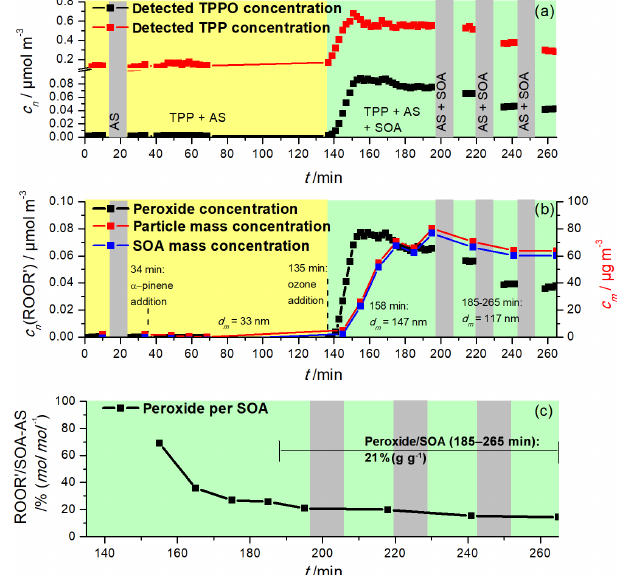
Figure 3. Time series of (a) the detected TPPO (black) and detected TPP (red), (b) the peroxide concentration (black) after background correction and particle mass concentration of the SOA–AS aerosol (red) and the SOA (blue), and the (c) relative contribution of perox- ide to the total aerosol volume (black; time resolution 10min). Pe- riods without the addition of TPP (AMS mode) are marked with a grey background; the period before the addition of ozone is marked in yellow and during the ozonolysis in green (with TPP, ORD-AMS mode). α -pinene was continuously added after 34min and ozone after